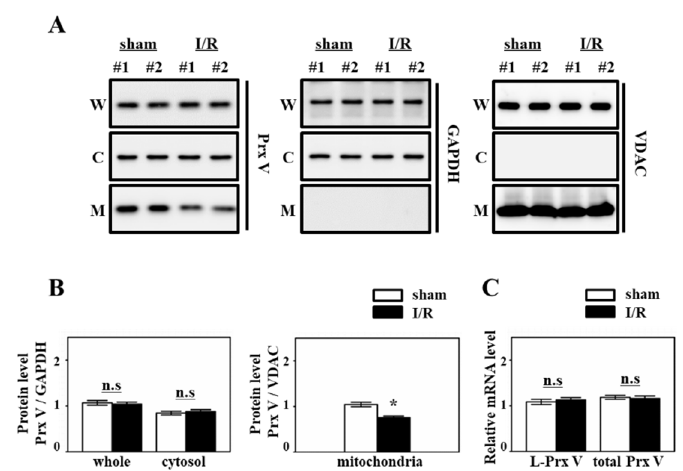
Figure 1. Prx V expression in mice during renal I / R. ( A ) Protein expression of Prx V was analyzed by immunoblotting. Kidneys were subjected to subcellular fractionation. W: whole lysates, C: cytosol fraction, M: mitochondrial fraction. ( B ) Prx V protein level of ( A ) was quantified by Multi Gauge V3.0 software (Fujifilm, Tokyo, Japan) and normalized to GAPDH as control of cytosolic protein or VDAC as control of mitochondrial protein. ( C ) The mRNA expression level of mitochondrial Prx V (L-Prx V) and total Prx V in I / R induced kidney. Data are shown as means ± SE. n = 4–6 / group * p < 0.05 vs. sham, not significant; n.s.